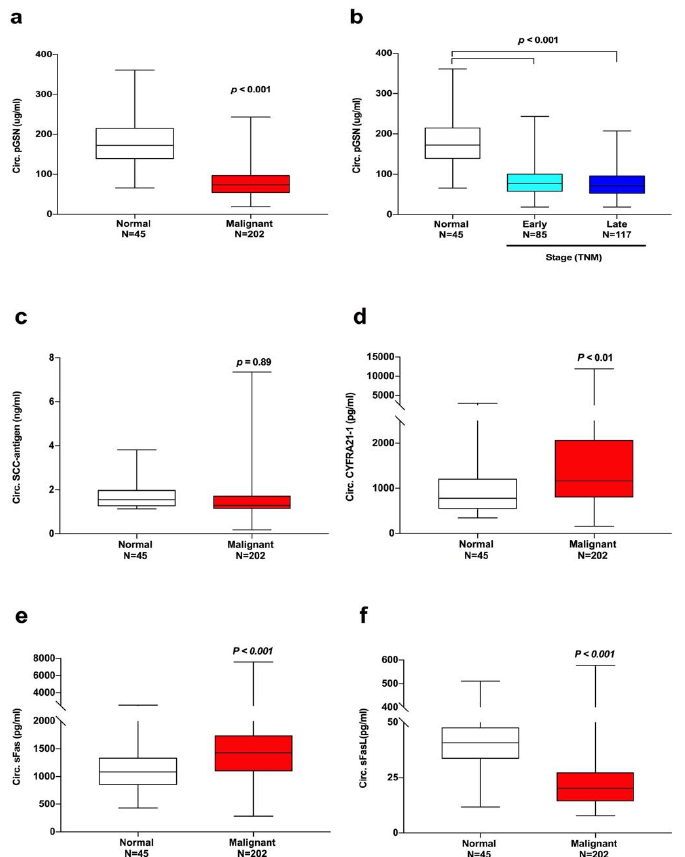
Figure 1. Circulating plasma gelsolin (pGSN) is the optimal diagnostic biomarker for head and neck cancer (HNC). ( a ) Circulating pGSN levels were significantly lower in patients with HNC (red bar, n = 202; 81.03 ± 38.14 μg/mL) than in healthy controls (white bar, n = 45; 181.7 ± 58.54 μg/mL; p < 0.001). ( b ) No significant difference existed between circulating pGSN levels in patients at early (stages I + II) versus advanced (stages III + IV) HNC stages, whereas the healthy controls presented distinctively higher circulating pGSN levels ( p = 0.89). Circulating ( c ) squamous cell carcinoma (SCC) levels exhibited no significant di ff erences between normal and malignant disease. Circulating ( d ) CYFRA21-1 and ( e ) soluble Fas (sFas) levels were significantly higher in patients with HNC than in healthy controls. ( f ) Circulating soluble FasL (sFasL) levels were significantly lower in patients with HNC than in healthy controls. Data are shown as mean ±